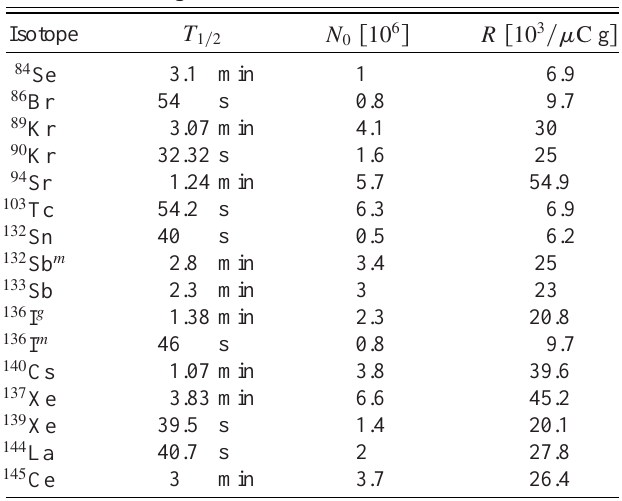
TABLE I. Production of neutron-rich species in a 1 mm thick U metallic disk by neutrons from a C target exposed to a 20 MeV, 100 nA deuteron beam. N 0 indicates the total number of atoms produced and R the rate per micro Coulomb of deuterons and gram of uranium.